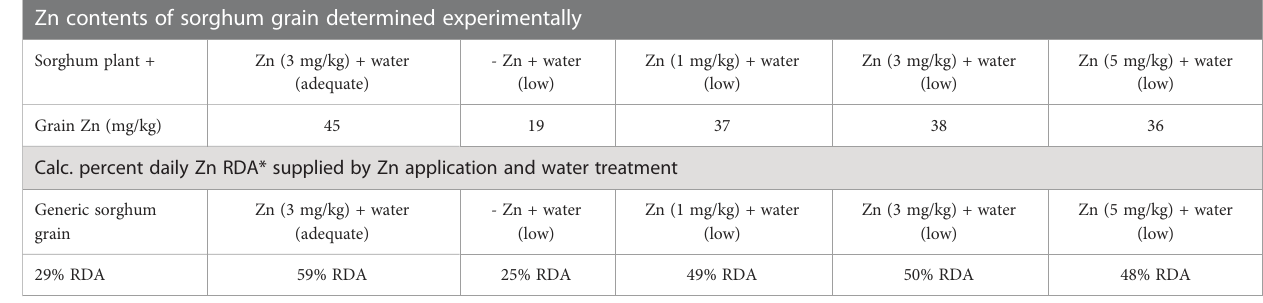
*RDA, Recommended Dietary Allowance (daily) calculated based on a 192 g sorghum grain